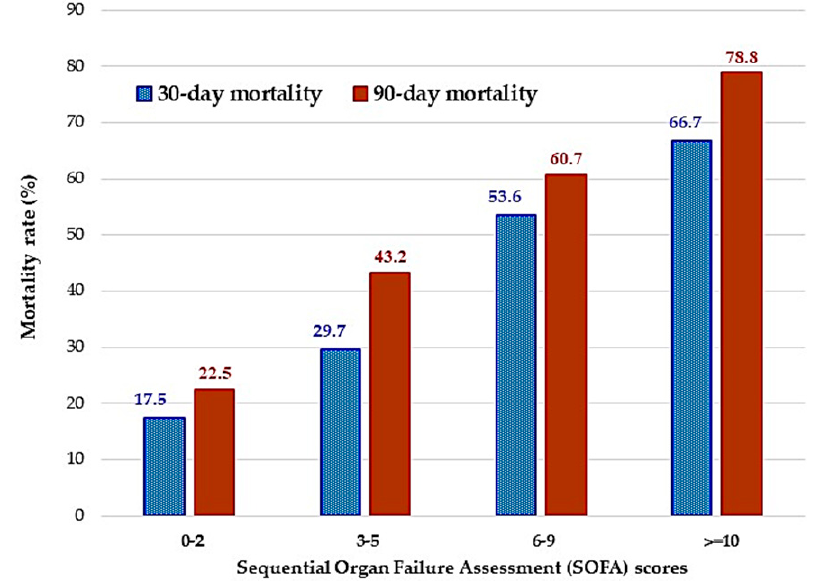
Figure 1. 30–day and 90–day mortality rates categorized by Sequential Organ Failure Assessment (SOFA) scores (0–2, 3–5, 6–9, and ≥ 10 points).